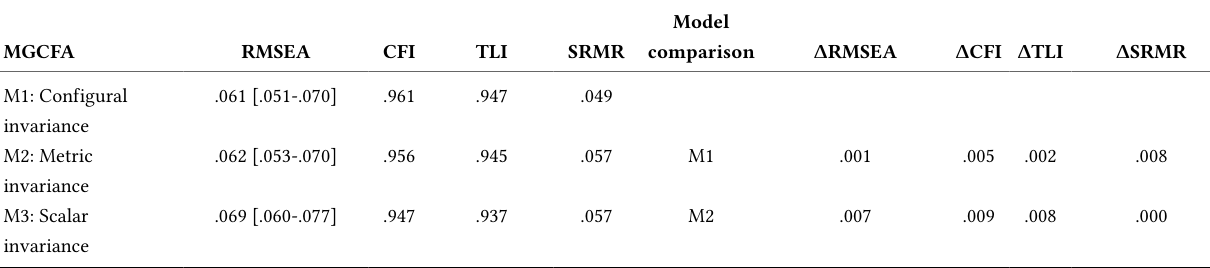
Multi-Group Confirmatory Factor Analysis For the Techno-Stress